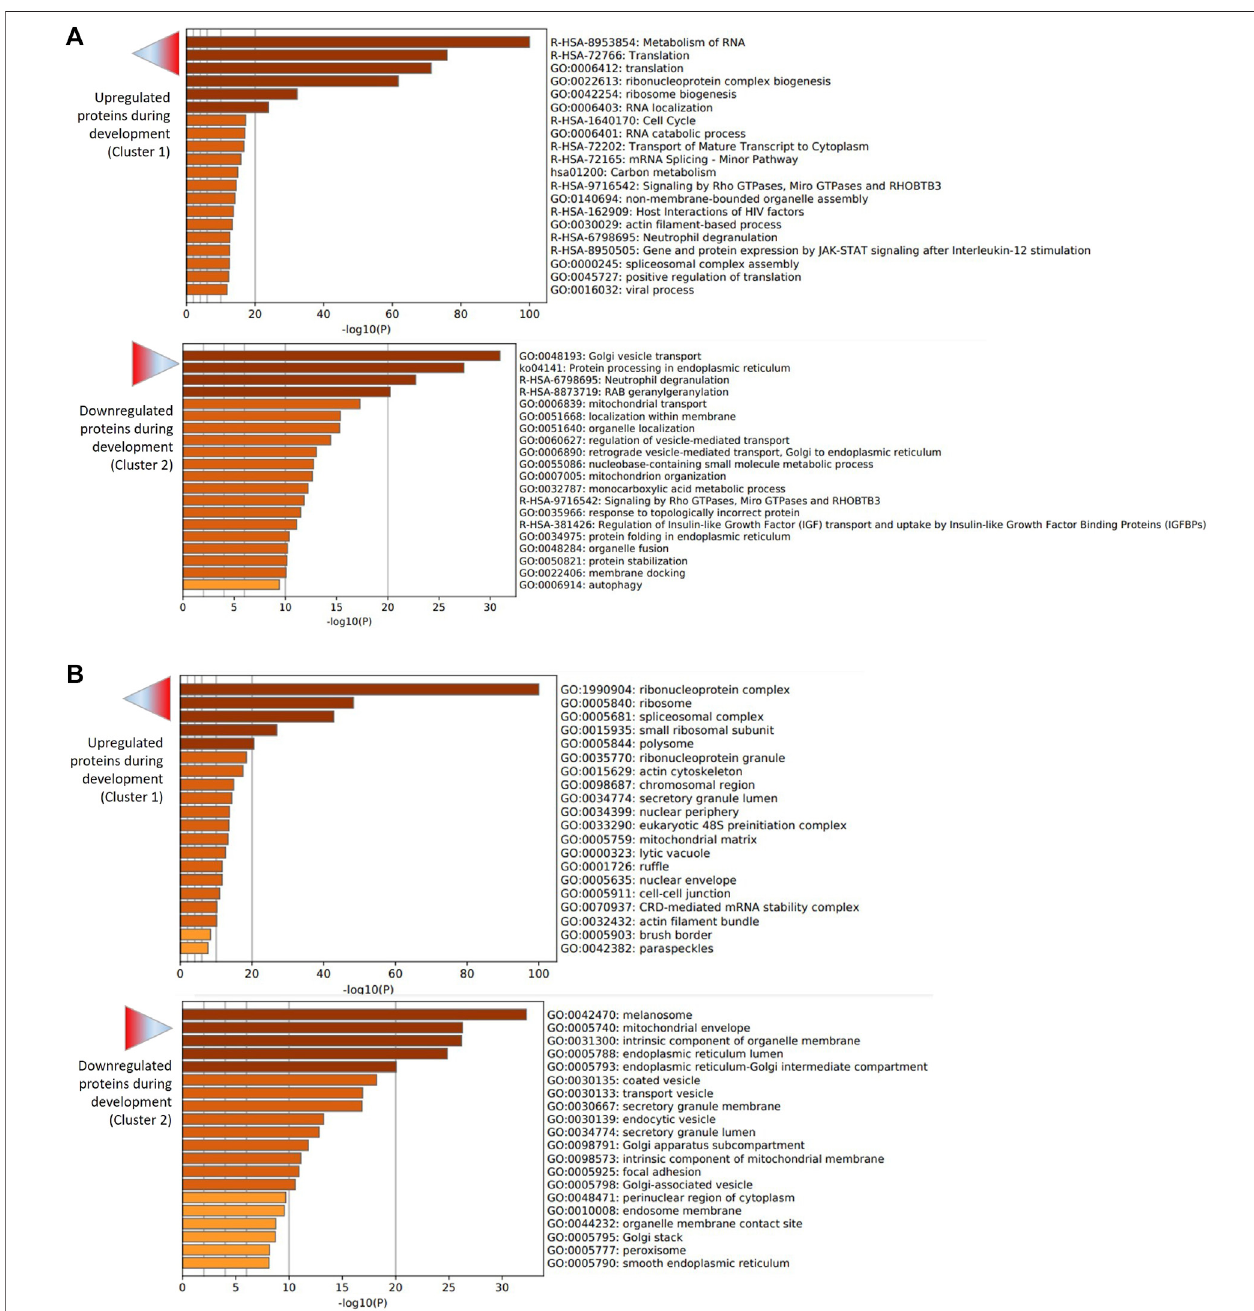
FIGURE 4 | Functionalenrichmentanalysisofupregulated(cluster1)anddownregulated(cluster2)proteinsduringembryodevelopment.Theanalysiswasperformed using Metascape. (A) Bargraph ofenrichedpathway and process terms for upregulated(top graph) and downregulated (bottom graph)proteins. (B) Bargraph ofenriched cellular component terms for upregulated (top graph) and downregulated (bottom graph) proteins. Darker color of bars indicates higher signi fi cance (lower p-value).